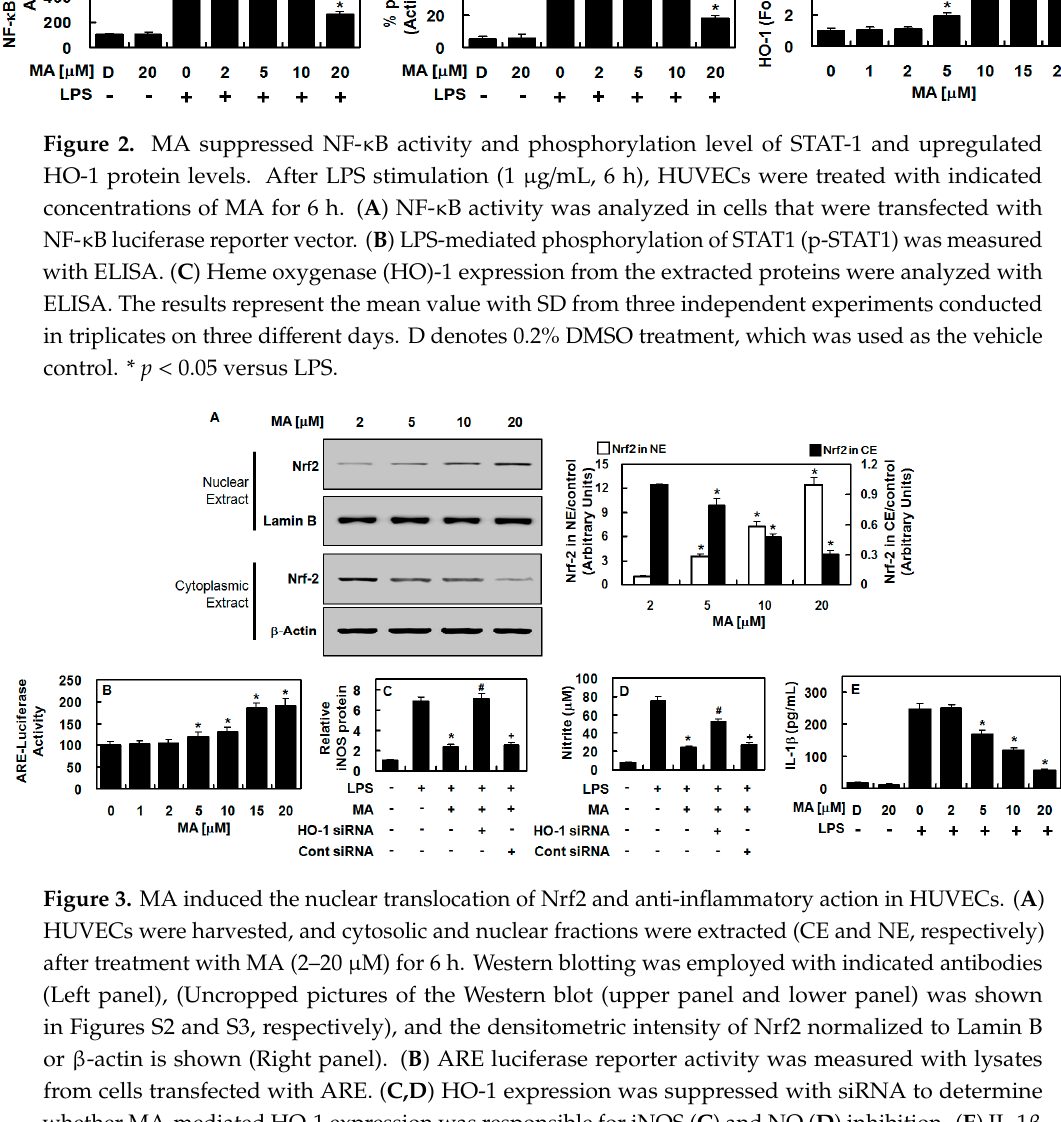
The anti-inflammatory e ff ect of MA was also validated by its suppression of IL-1 β production in LPS-treated HUVECs (Figure 3E).